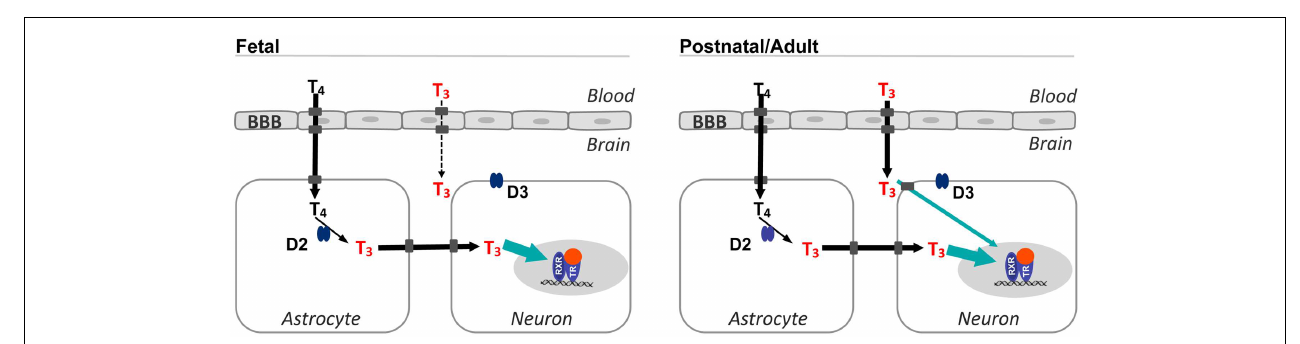
without naming any specific transporter. Although in the rodent brain, the BBB expresses Mct8 and Oatp1c1, the latter is not present in the primate BBB.T4 enters the astrocytes most likely through Oatp1c1. Passage ofT3 from astrocytes to neurons is facilitated by Mct8 and also other transporters, since in Mct8 KO mice there is no apparent restriction for the passage of astrocyticT3 to neurons.Type 3 deiodinase is localized in the plasma membrane of neurons. BBB, blood–brain barrier; D2, type 2 deiodinase; D3, type 3 deiodinase;TR, thyroid hormone receptor; RXR, 9-cis retinoic acid